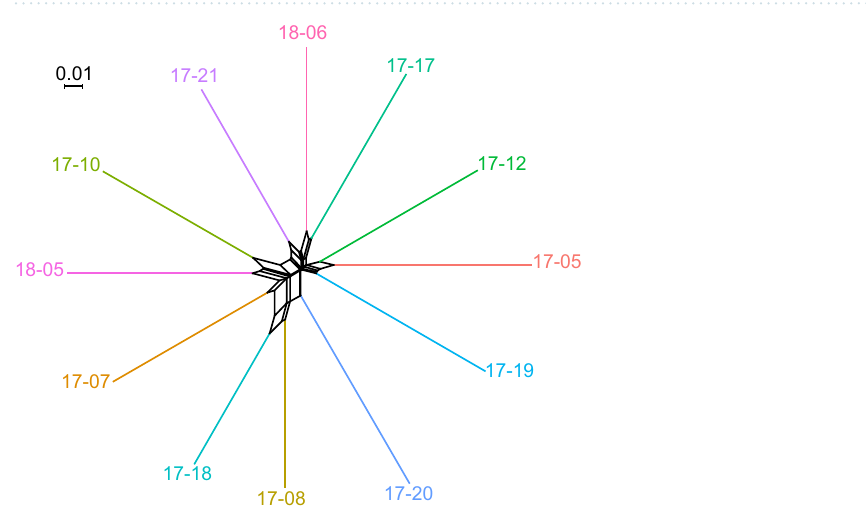
Figure 2. PCA exploring population structure in EGSB stock bowhead whales sampled in 2017 and 2018. No obvious population structuring was identified.